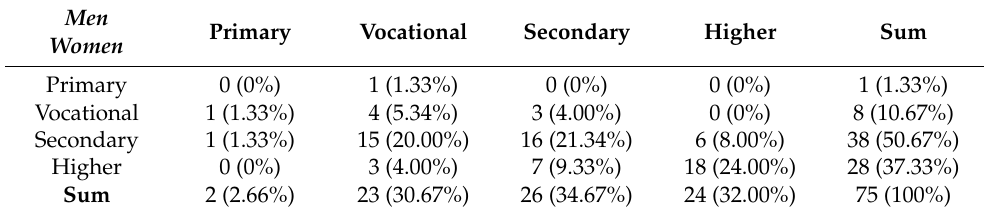
Table 1. The educational level of examined people.